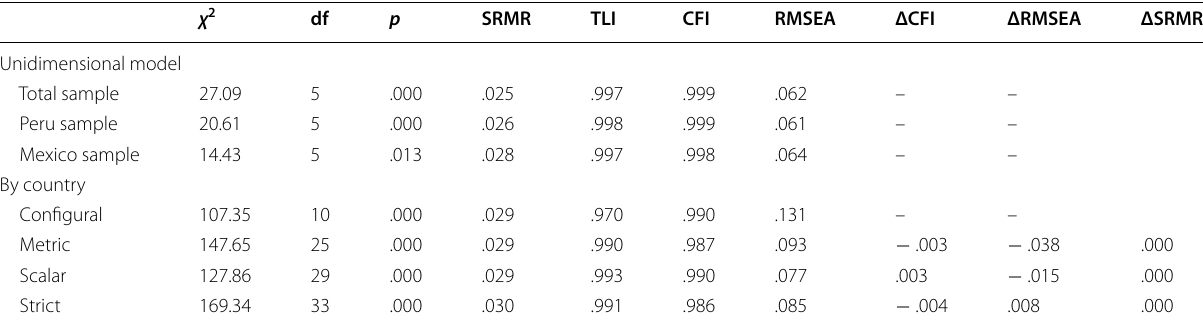
Table 3 Fit indices and invariance